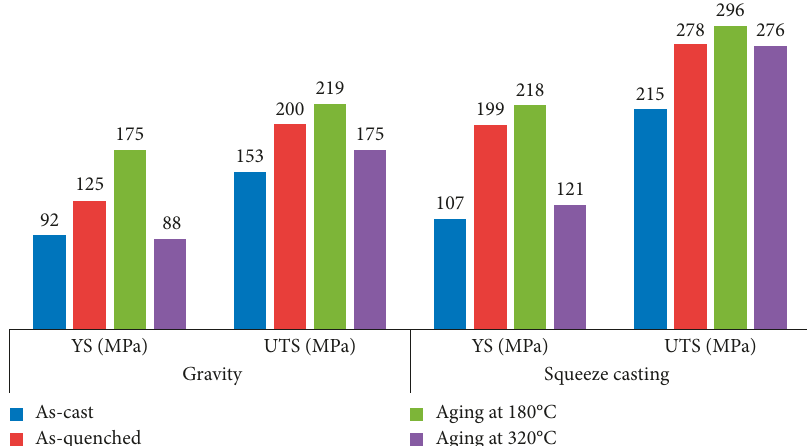
Figure 8: YS and UTS of the gravity die cast and the squeeze cast alloy under 90MPa pressure in the different treatment conditions.